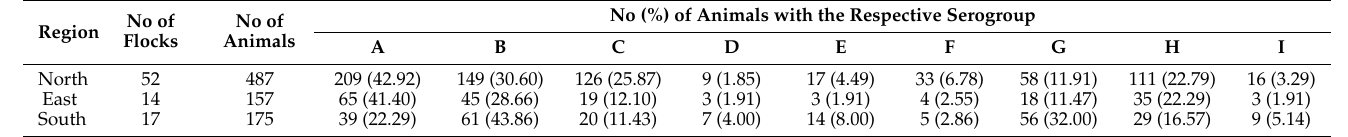
Table 3. Distribution of the serogroups by the three different regions of Germany at the animal level. Number and percentage of animals with the respective serogroups. The percentages refer to the number of animals with serogroups detected in the respective regions ( n = 819).